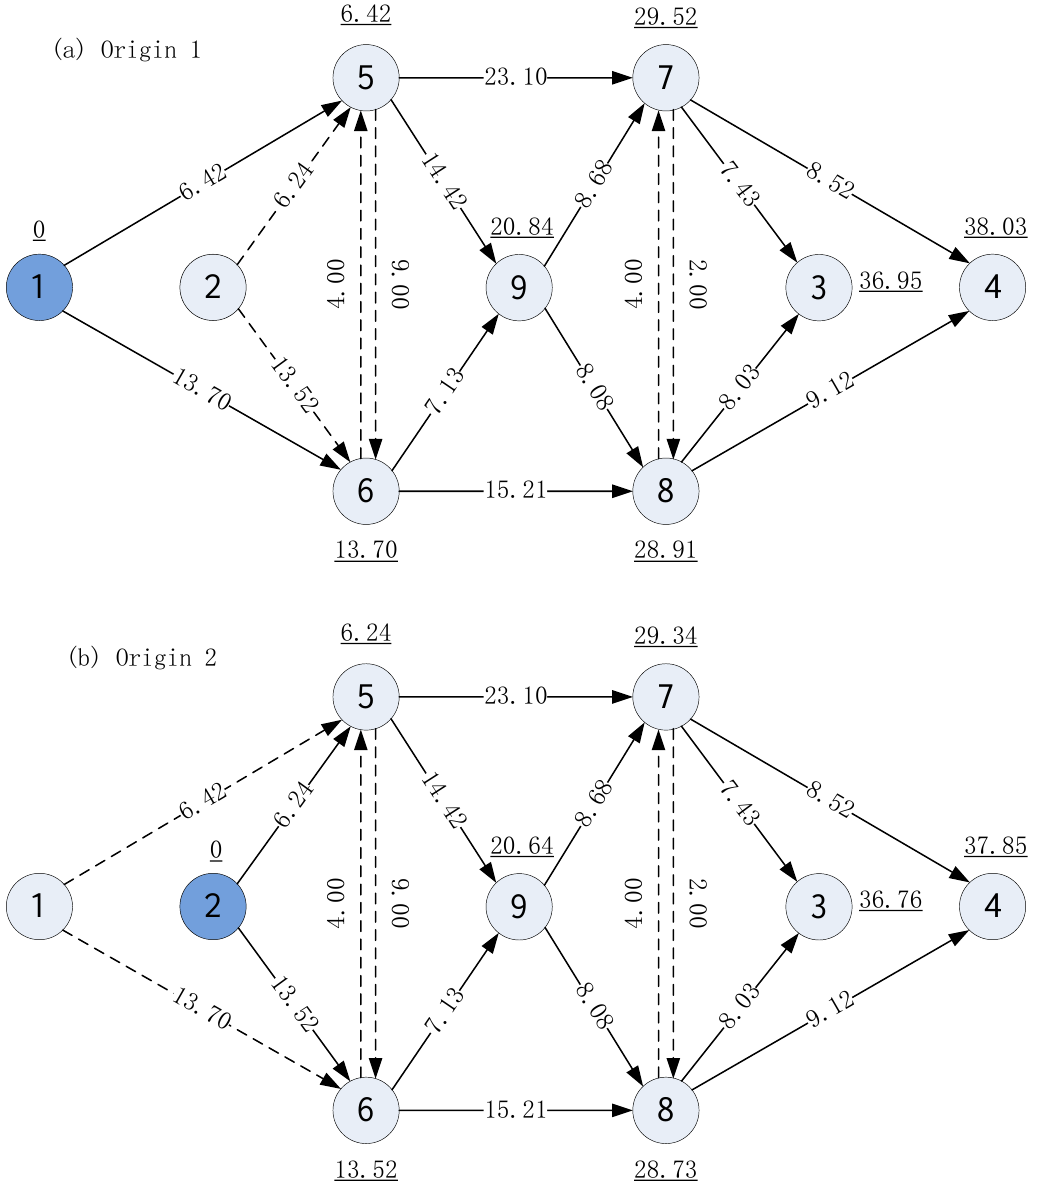
Figure 5: Subgraphs, node potentials and generalized cost under MC